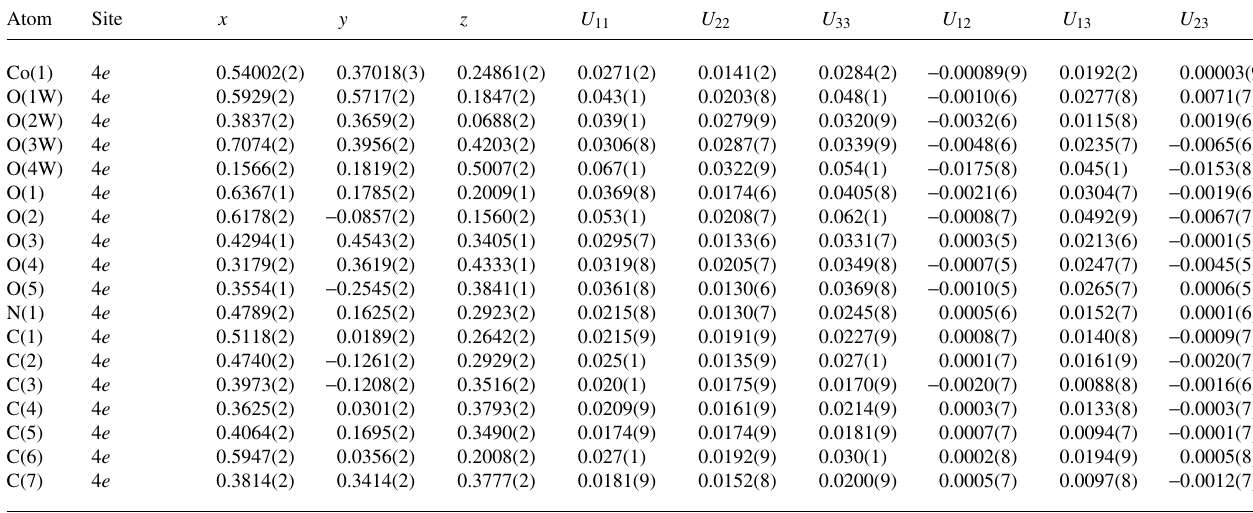
Table 3. Atomic coordinates and displacement parameters (in Å 2 ) .